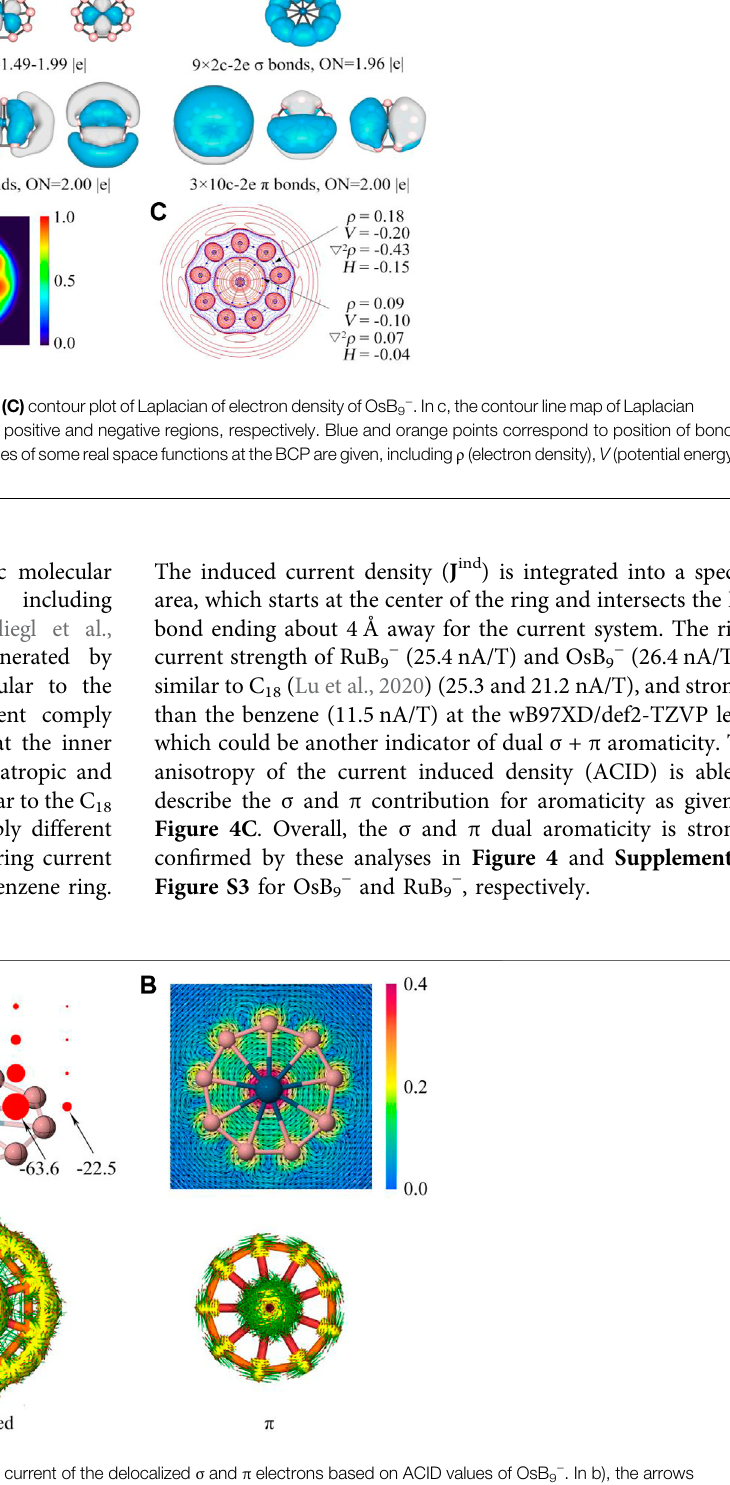
FIGURE 4 | (A) NICS zz , and (B) GIMIC map and (C) induced ring current of the delocalized σ and π electrons based on ACID values of OsB 9 − . In b), the arrows indicate direction of induced current, the color correspond to magnitude of induced current.